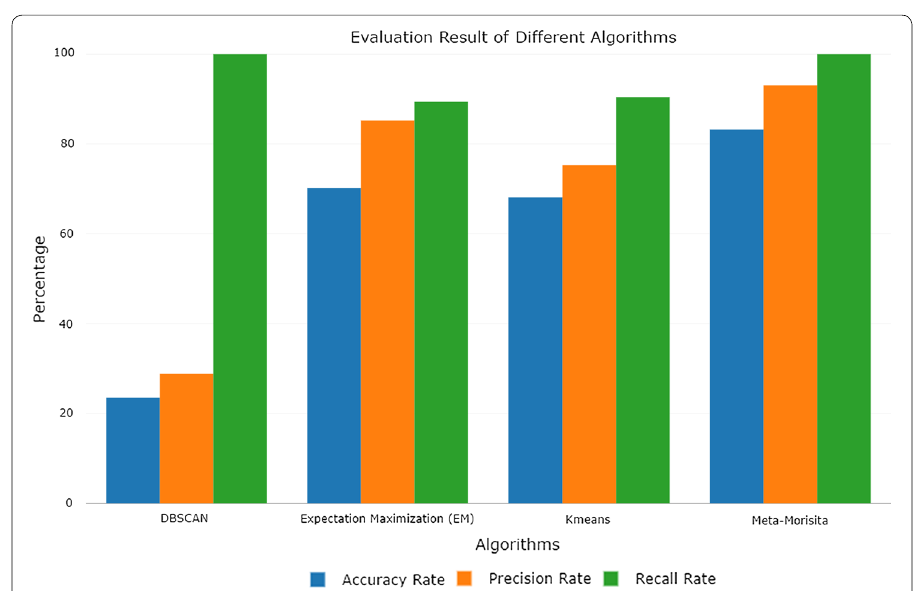
Fig. 22 Evaluation comparison among K-means clustering, DBSCAN and EM Clustering